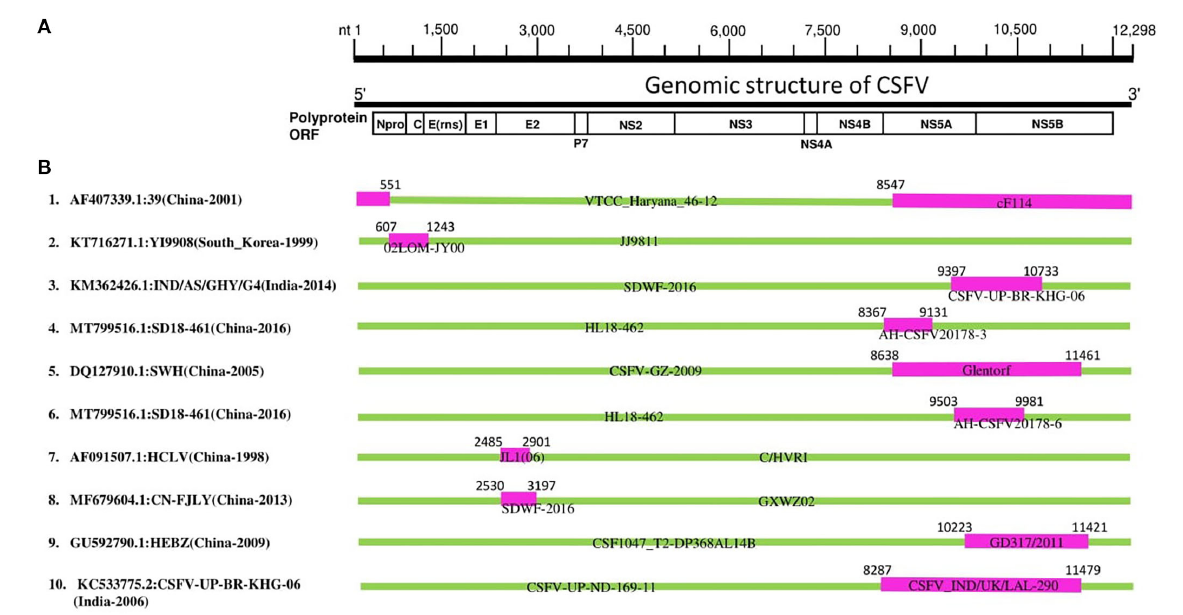
FIGURE2 CSFV complete genome recombination. (A) Diagram showing the full-length genome of CSFV strain GD 19/2011 (GenBank ID: KU 504339) and the corresponding regions encoding N pro C, Erns, E1, E2, p7 N2, NS3, NS4A, NS4B, NS5A, and NS5B. (B) Schematic representation of potential recombination events listed in Supplementary Table 2. The recombination event serial number and the description of potential recombinants (GenBank ID: virus name/country-collection year) are shown on the left. The filled pink and green blocks represent the genomic regions from minor or major parent viruses, respectively. The numbers on the top of filled green blocks indicate the nucleotide positions of breakpoints on the corresponding recombinant